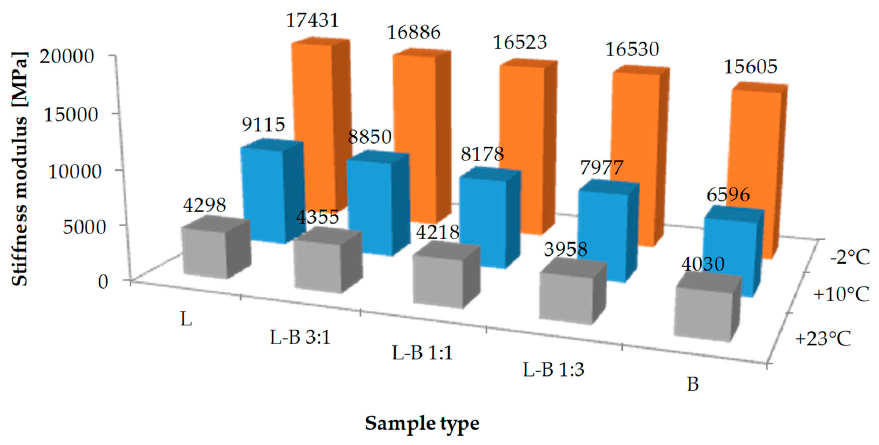
Figure 10. Average stiffness modulus values of studied mixes.